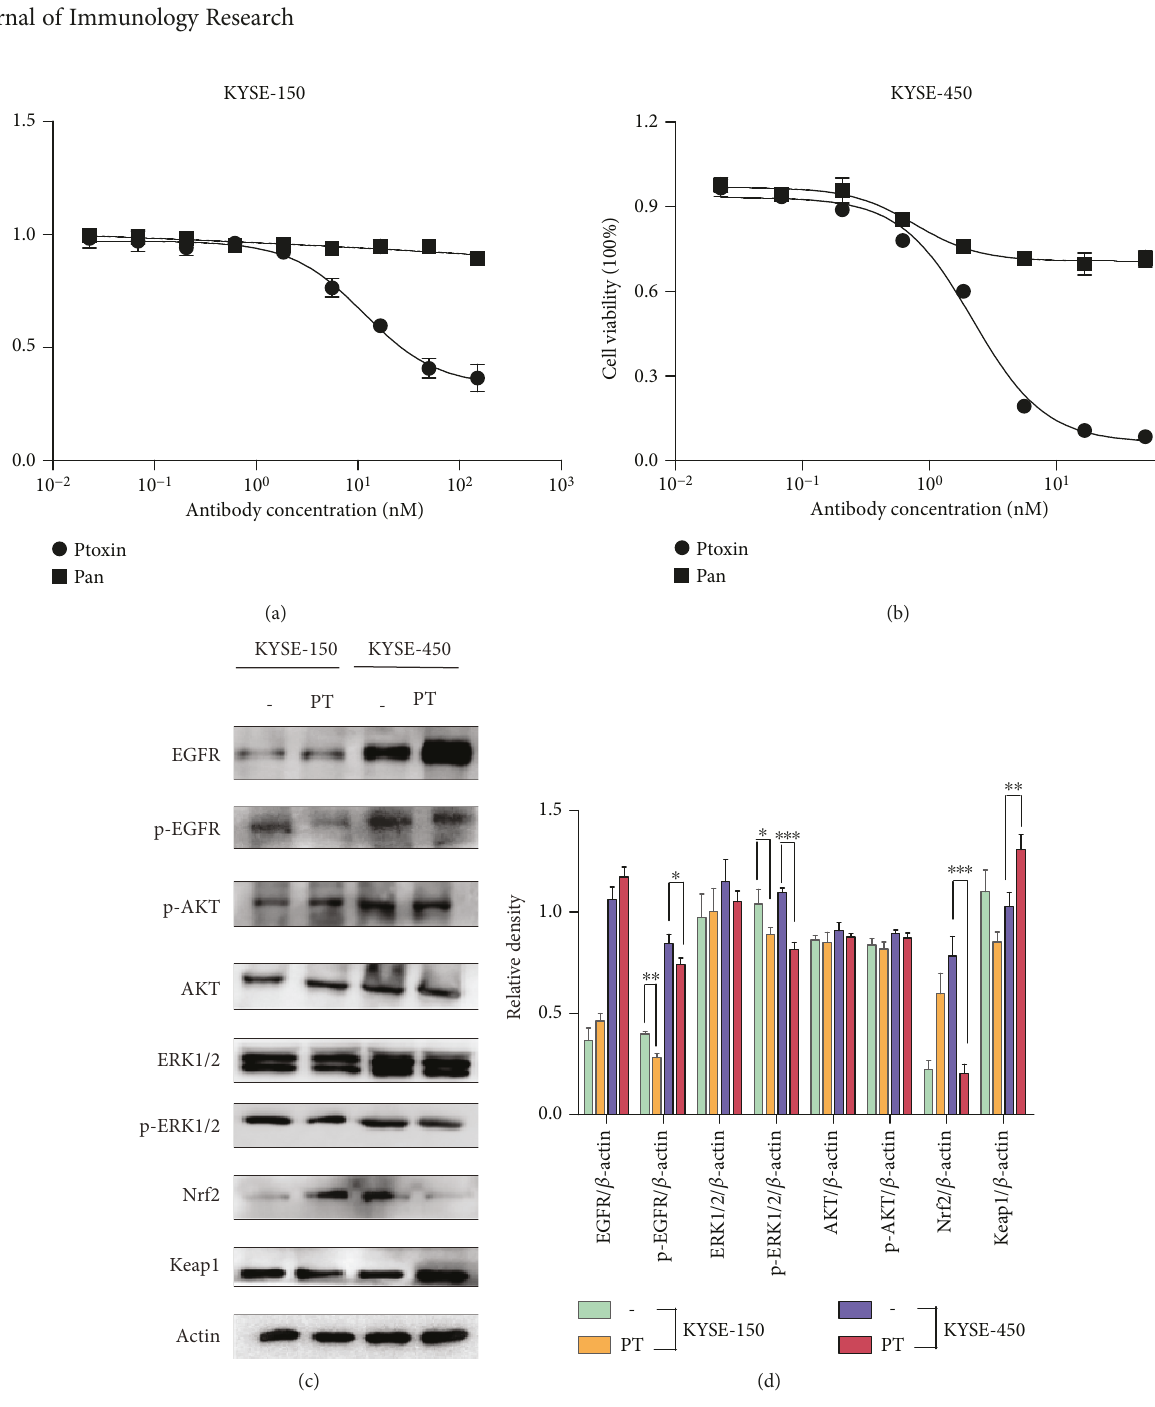
Figure 3: Treatment with PT inhibited the growth of esophageal cancer cells, and EGFR downstream signaling molecules were examined by western blot. (a) CCK-8 assay showing the inhibitory e ff ects of Ptoxin on growth of KYSE-150 cells. IC50 is 11.43nM (95% CI: 8.578- 15.24nM) for PT. Bars: SD. (b) CCK-8 assay showing the inhibitory e ff ects of PT on growth of KYSE-450 cells. IC50 is 2.195nM